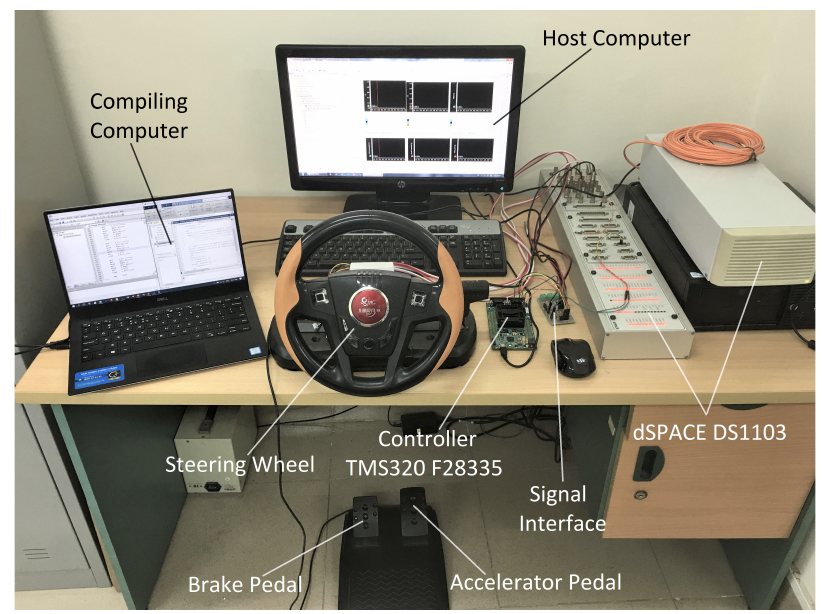
Figure 3. The Complete Hardware-in-the-loop Simulation System.